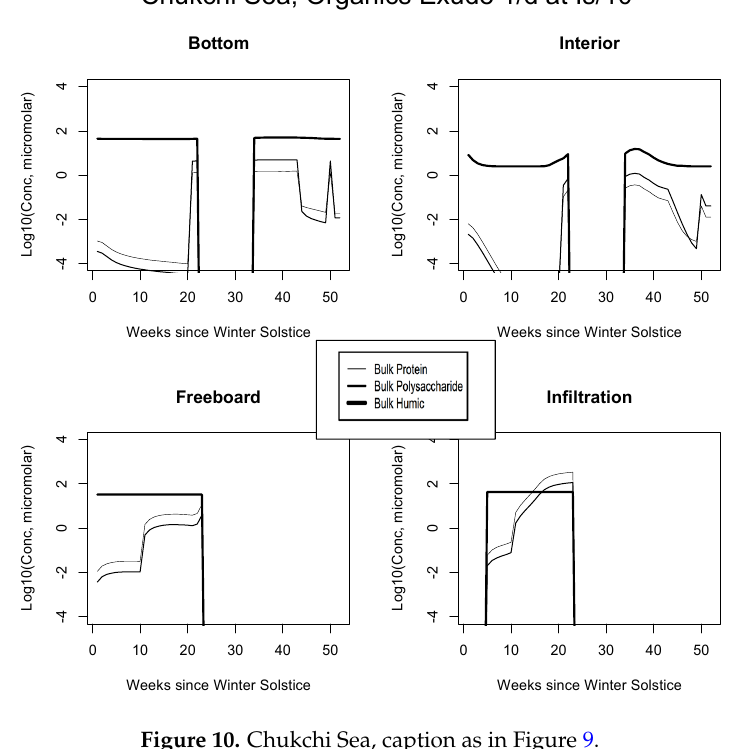
Figure 9. Sea of Okhotsk. Time evolution for bulk organic concentrations from the light-dependent run, for the four habitat levels. Values are base 10 logarithms for carbon in micromolar. Lipid profiles closely follow proteins or polysaccharides and for simplicity are not shown.